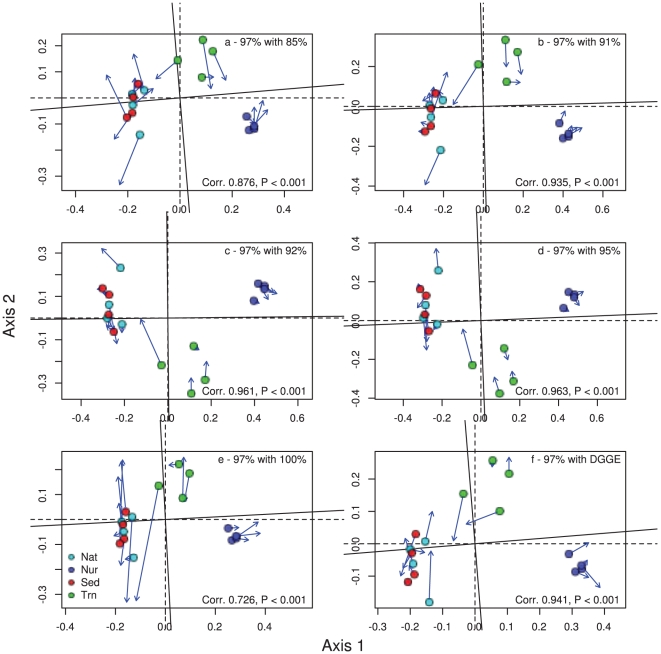
Ordination showing the first two PCO axes of the Alphaproteobacteria only analysis for a) 85% cut-off level with 97%, b) 91% cut-off level with 97%, c) 92% cut-off level with 97%, d) 95% cut-off level with 97%, e) 100% cut-off level and f) DGEE data with 97% cut-off level.The arrows in the ordination point to the target configuration, the actual symbols represent the rotated configuration, i.e., the ordination based on the 97% cut-off values. Correlation (Corr) and significance values are given in the lower right corner of each graph.